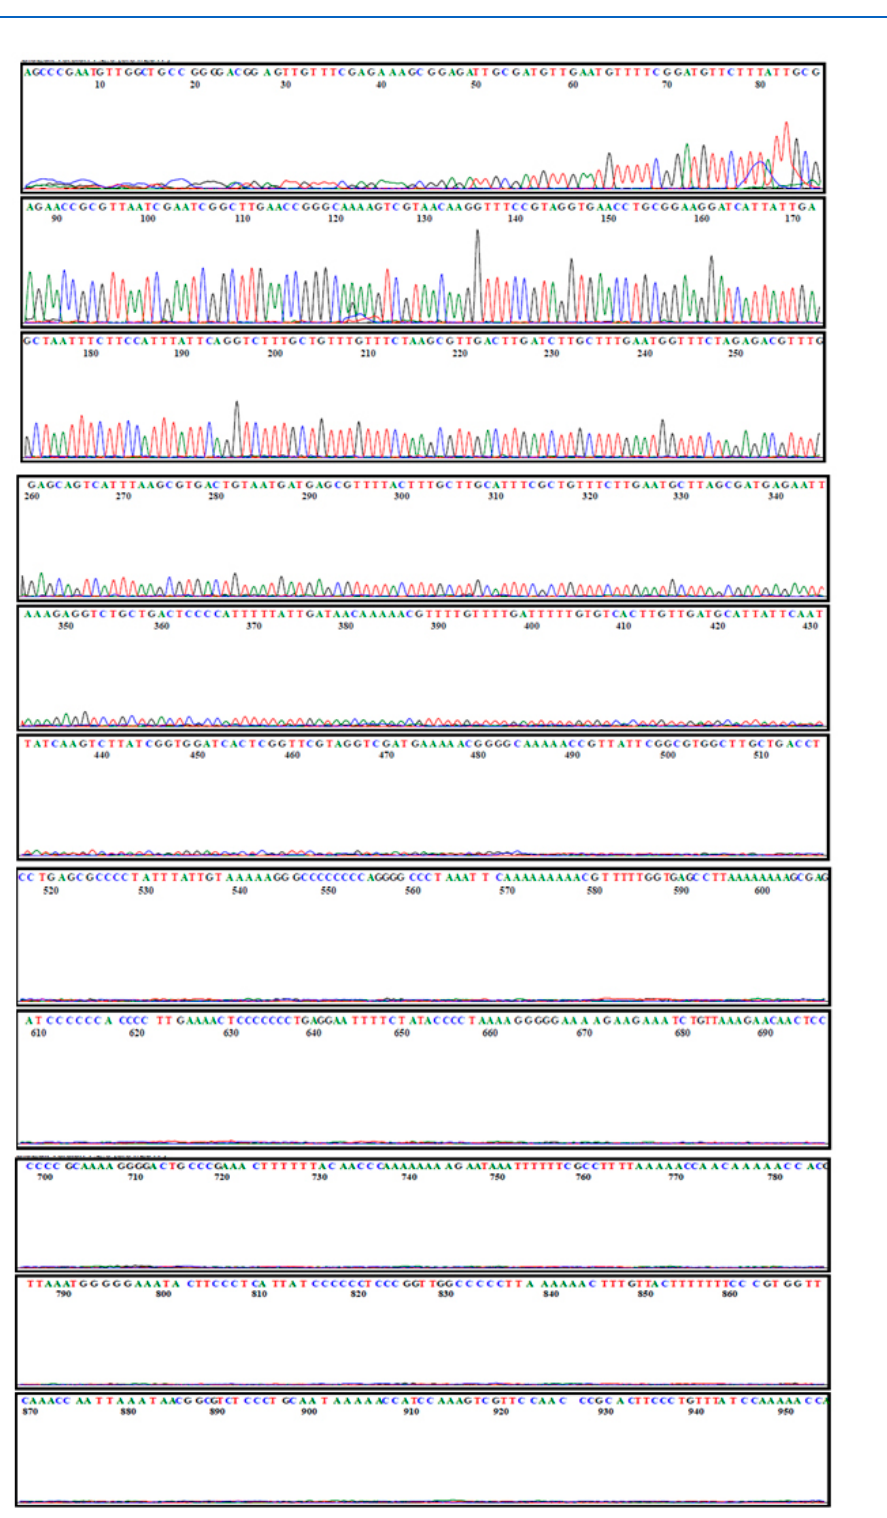
Fig. 1b. Chromatogram sequence analysis of Steinernema siamkayi